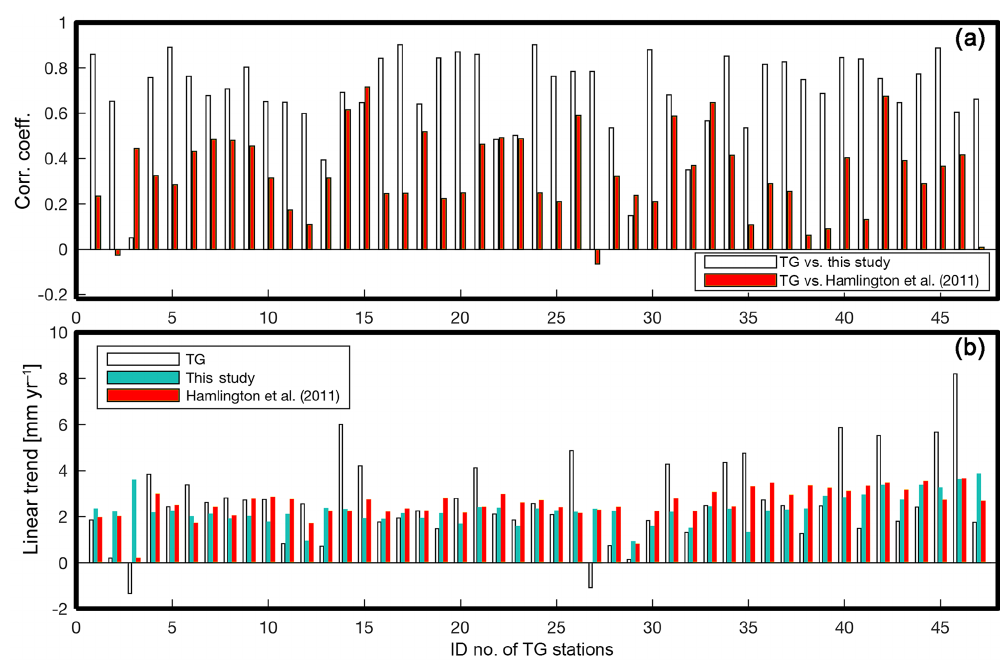
Figure 10. (a) Comparison of correlation coefficients between TGs and the reconstructions over 1970–2008; (b) comparison of linear trends over 1970–2008.